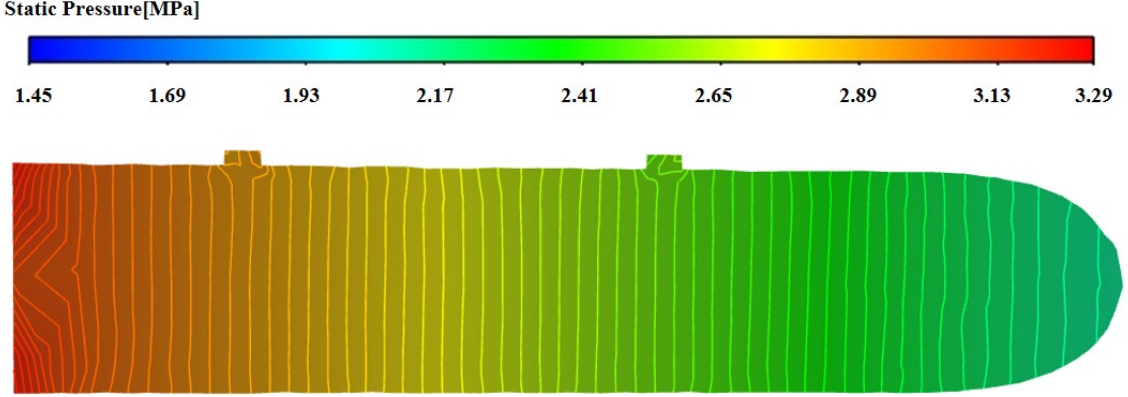
Figure 12. The interior pressure condition caused by crude oil